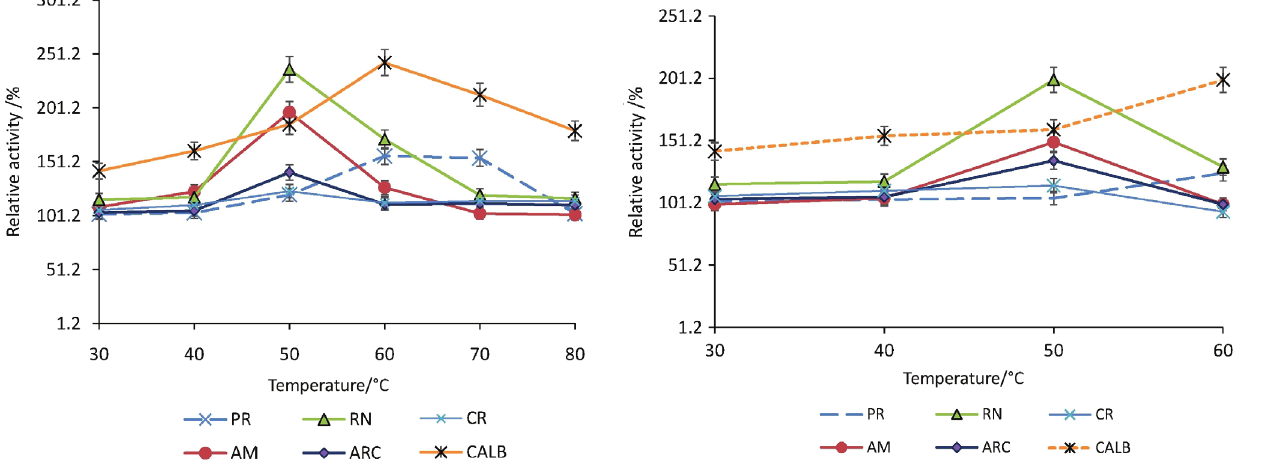
Fig. 4d – Stability of lipases at the optimal range of tem- peratures in the presence of 40 % NADES3 compared to the initial activity after incubation for 12 hours. Lipase from por- cine pancreas (PR), lipase from Candida rugosa (CR), Amano lipase PS, from Burkholderia cepacia (AM), lipase from Rhizo- pus niveus (RN), lipase acrylic resin from Candida antartica (ARC) (recombinant, expressed in Aspergillus niger), Lipase B Candida antartica immobilized on Immobead 150, recombinant from Aspergillus oryzae